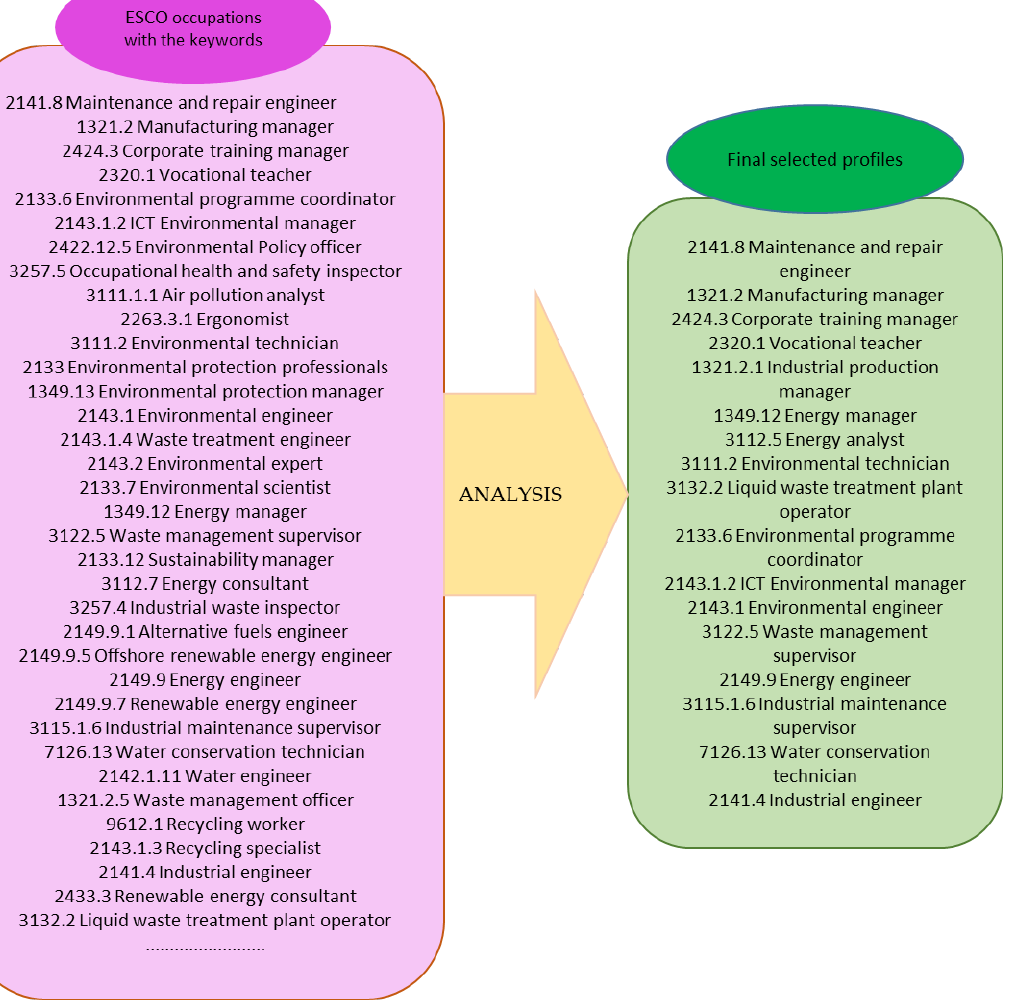
Figure 1. The process of selecting the relevant IS- and EE-related job profiles of the manufacturing industry and the final 17 ESCO profiles selected after the analysis (on the right).